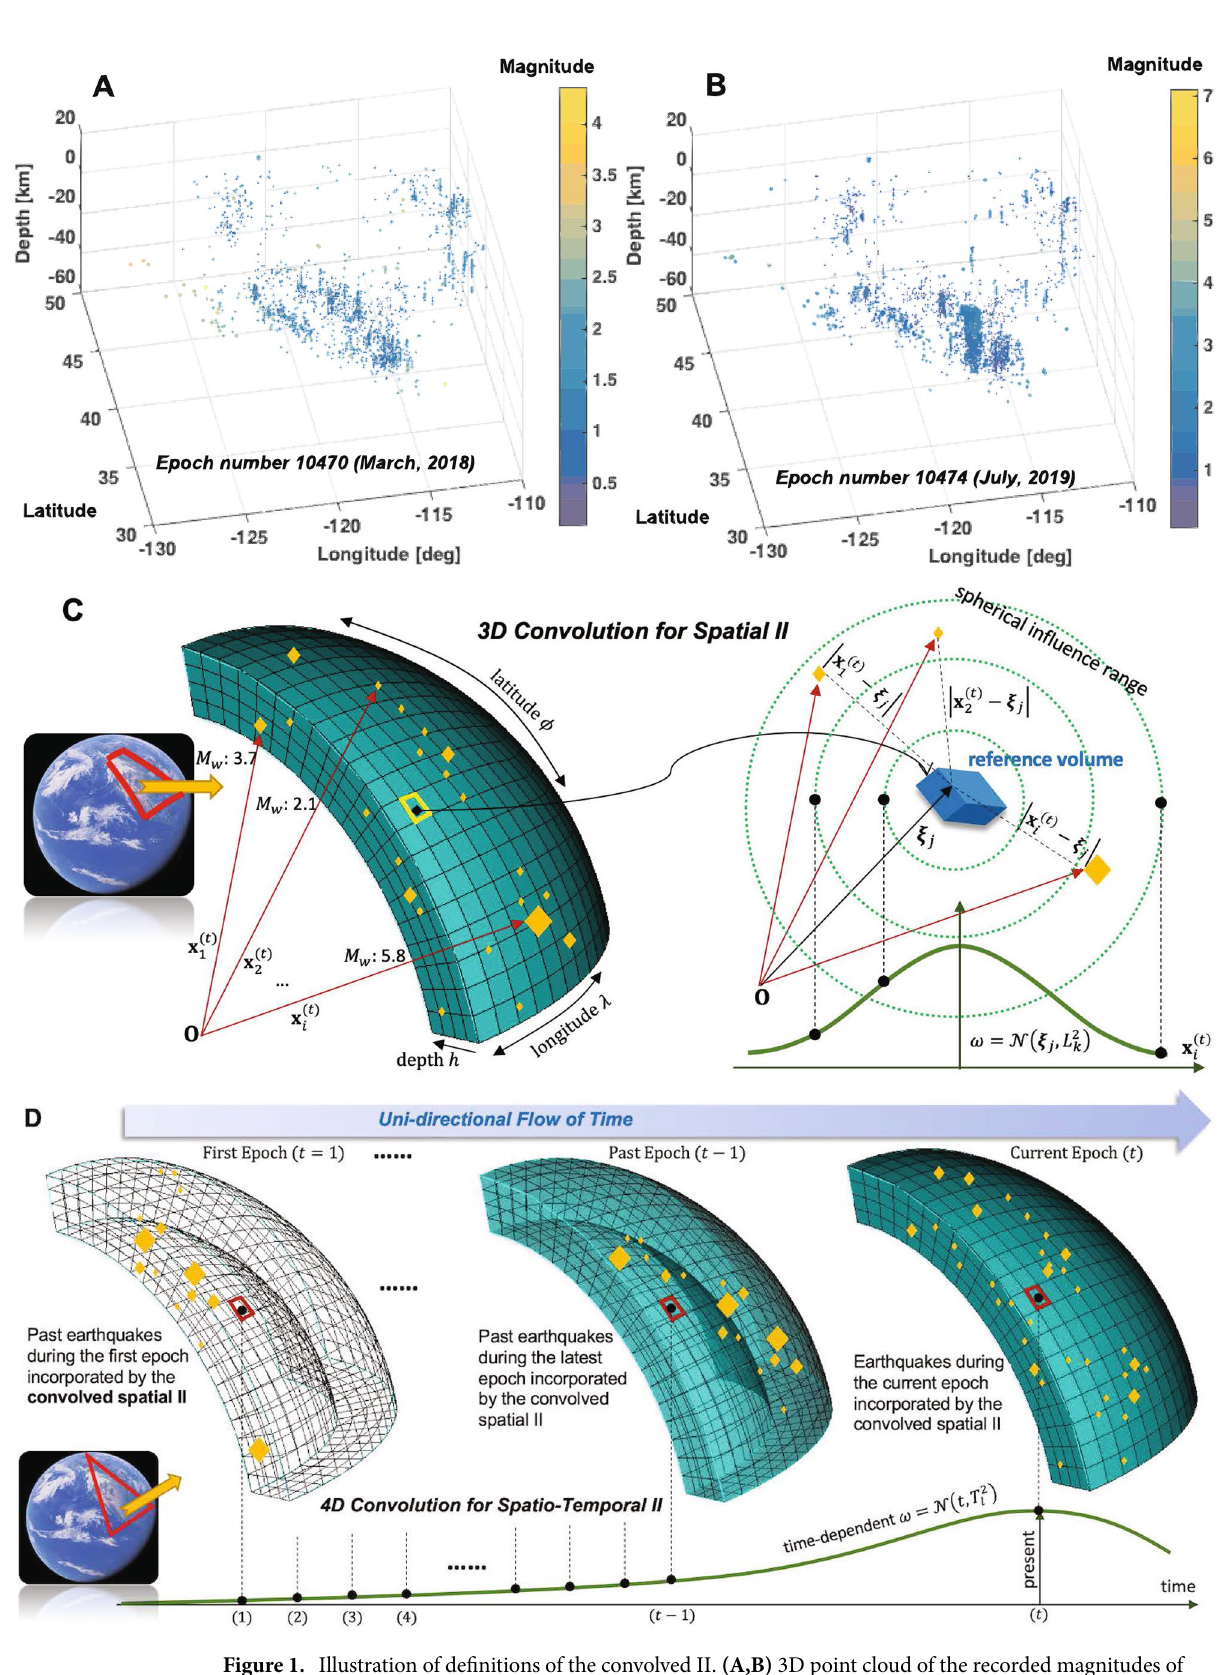
Figure 1. Illustration of definitions of the convolved II. (A,B) 3D point cloud of the recorded magnitudes of two example epochs (months) of the West region in the U.S. (C) Definition of the convolved spatial (3D) II. One reference volume accumulates the impacts of earthquakes during one epoch with the 3D Gaussian weights. (D) Convolved spatio-temporal (4D) II. Using the half Gaussian weight, all the past earthquakes are incorporated with time-decaying